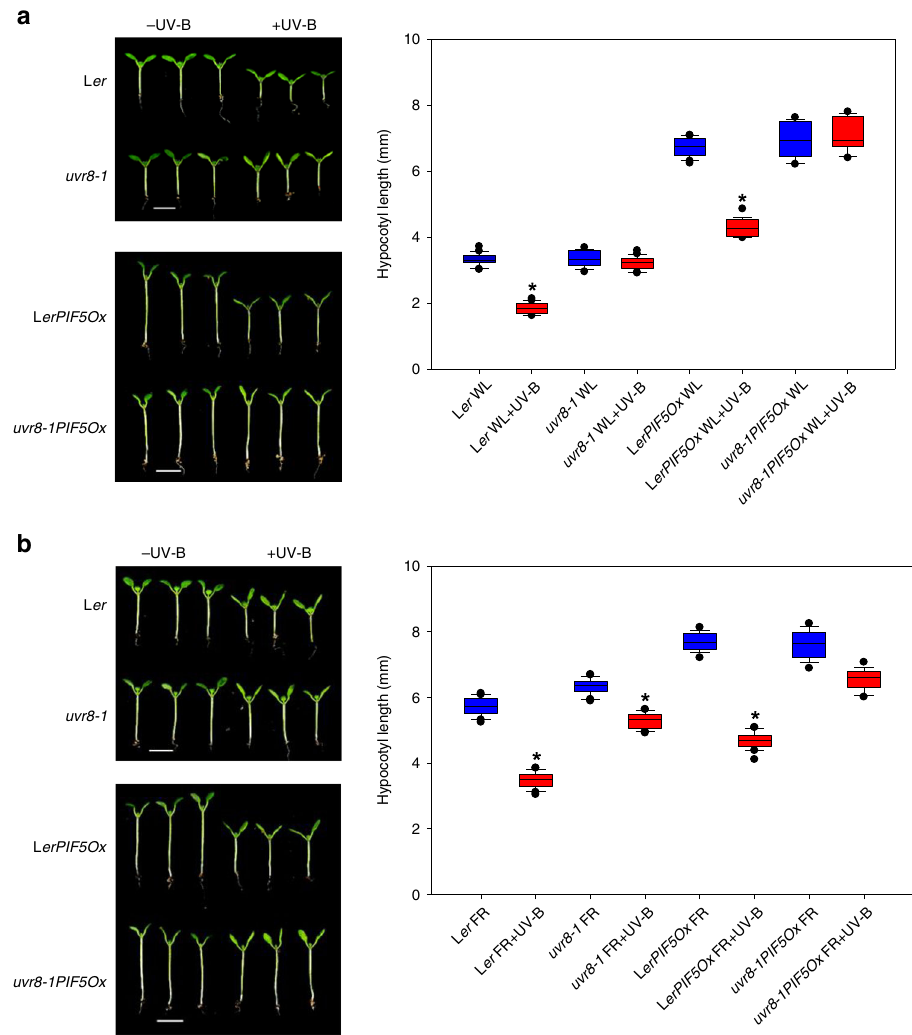
Fig. 1 UV-B perceived by UVR8 inhibits PIF5-mediated hypocotyl elongation. Representative seedling images and hypocotyl length measurements of L er, uvr8-1 , L erPIF5Ox and uvr8-1PIF5Ox seedlings grown for 3 days in continuous high R:FR light before transfer to ( a ) high R:FR (WL) or ( b ) low R:FR (FR) for 4 days ± UV-B. Boxes represent 25th to 75th percentile. Bars show the median and whiskers represent the 10th and 90th percentile outlines. *Signi fi cant differences when compared to controls without UV-B treatment (Tukey ’ s HSD, P < 0.01, n ≥ 14). Scale bar = 4 mm. Source data are provided as a source data fi